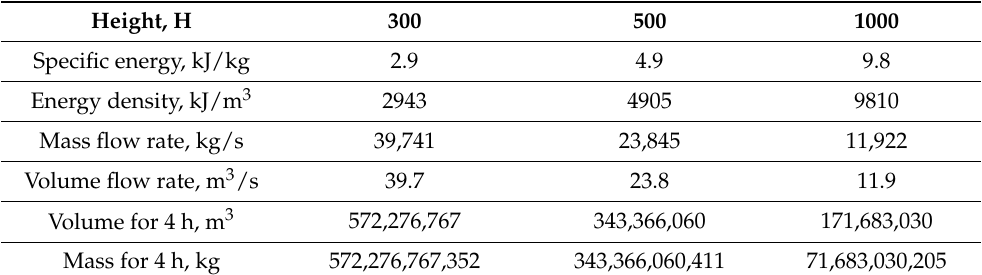
Table 1. The effect of the height, H, the specific energy, the energy density, the mass flow rate, the volume of water and the mass of water withdrawn after four hours of continuous